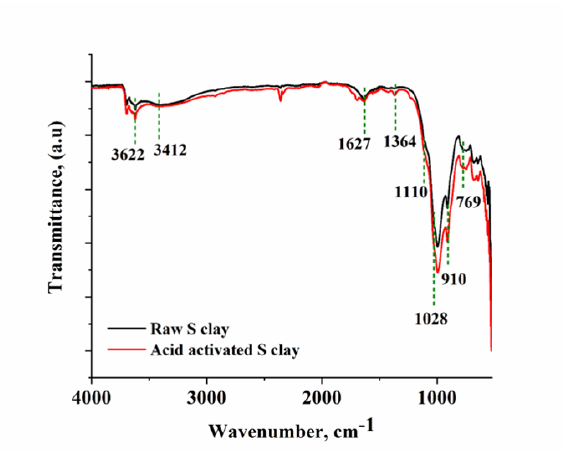
Figure 2: FT-IR spectra of raw and acid-activated Siththandy (S) clay